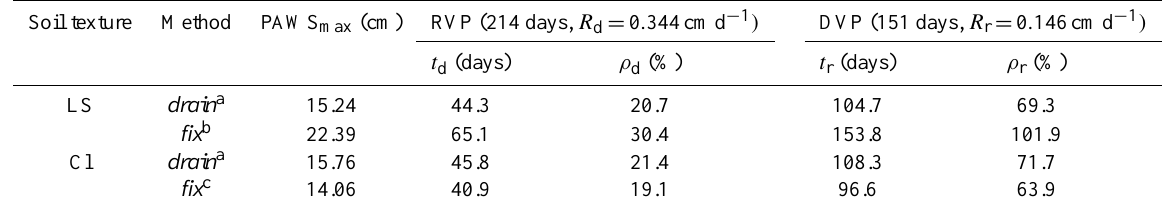
Table 6. Characteristic time scales of the bucket model during the DVP and RVP periods computed for the loamy-sand (L-S) and the clay (Cl)